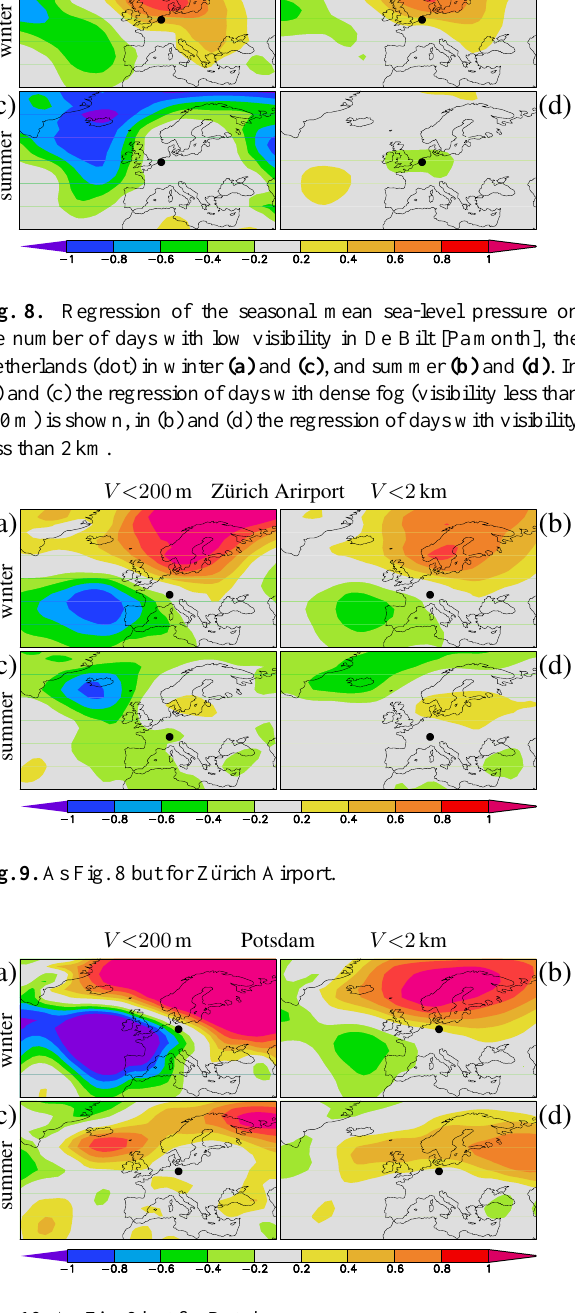
Fig. 10. As Fig. 8 but for Potsdam.